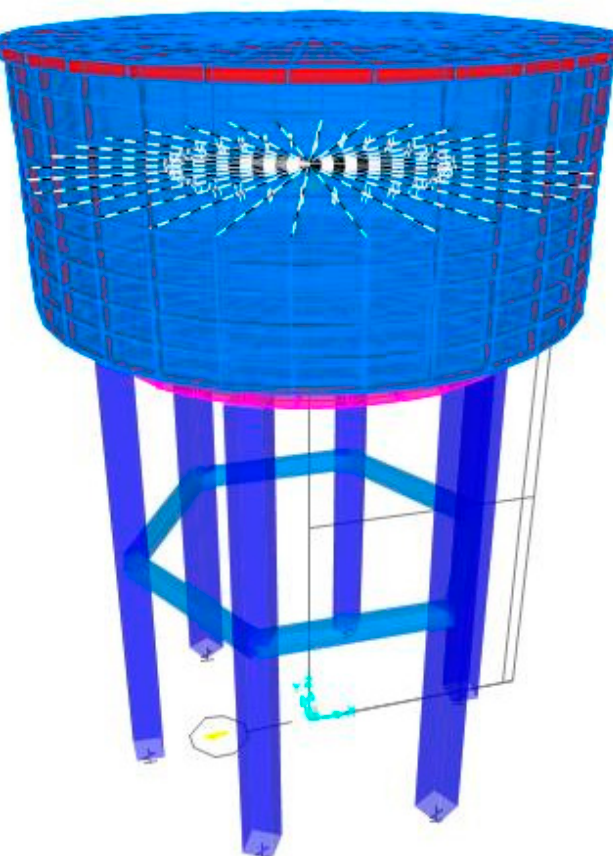
Figure 3. A 3D finite element model of the case study tank.